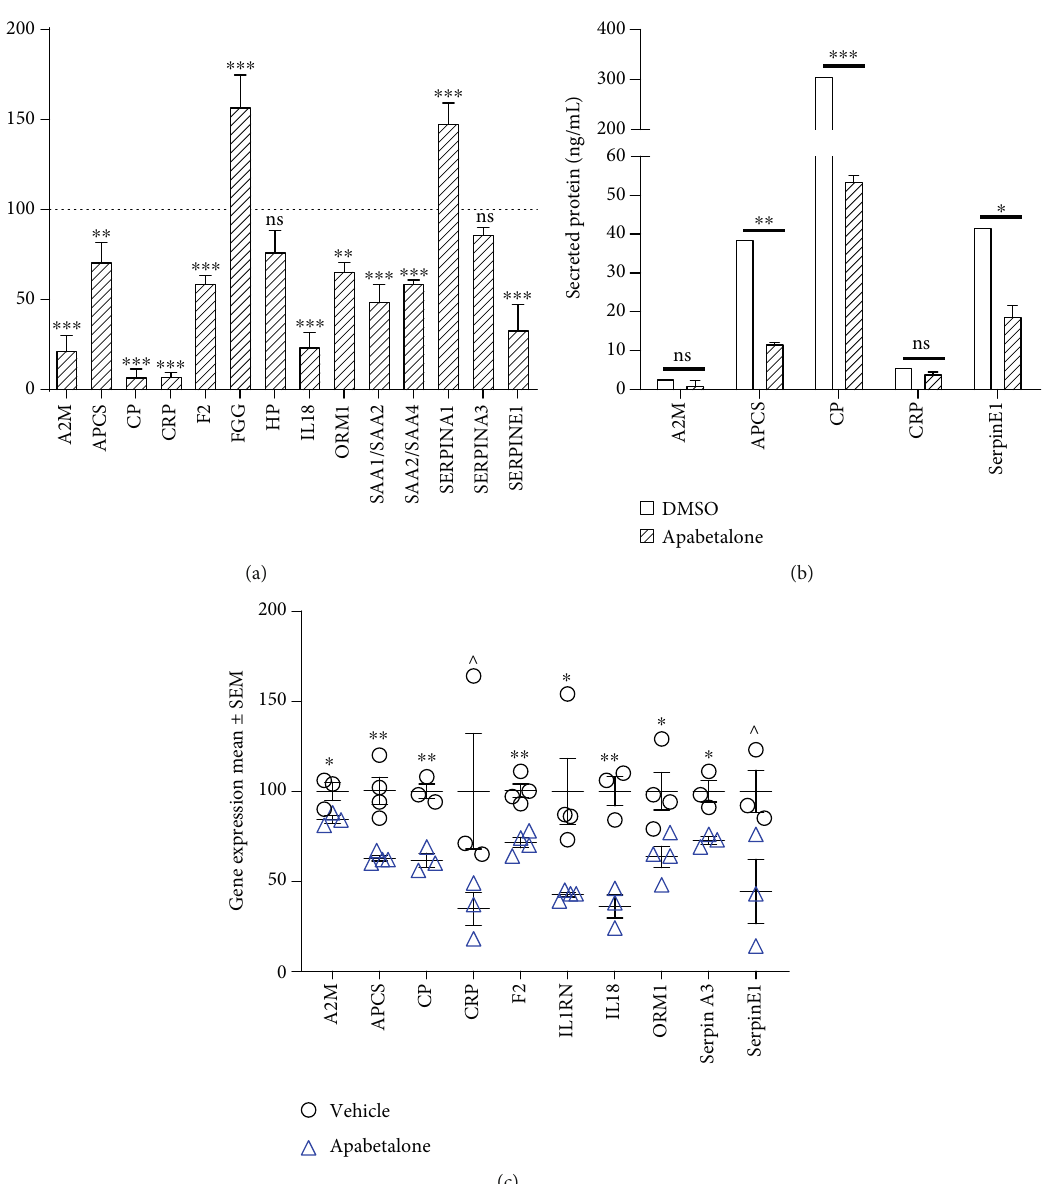
Figure 1: Apabetalone alters basal expression of genes within the APR pathway under nonin fl ammatory conditions in human hepatocytes. (a) rtPCR shows that apabetalone (30 μ M) treatment decreases the expression of APR genes (72 h). Gene expression is normalized to vehicle (DMSO) treated cells. (b) Apabetalone (30 μ M) decreases APR protein secretion after 72 h of treatment. Protein secretion in the fi nal 24h of treatment is measured by ELISA and is expressed as nanograms per milliliter of tissue culture media. Representative data mean ± S : D : is shown. (c) APR gene expression in humanized liver of chimeric mice. Mice received 150 mg b.i.d. apabetalone or vehicle treatment for 1 to 3 days. Mean data normalized to naïve samples ± S : E : M : is shown. Statistical signi fi cance was determined through t - test comparison of vehicle and apabetalone treatment, where ∗ p < 0 : 05 , ∗∗ p < 0 : 01 , ∗∗∗ p < 0 : 001 , and ns means no signi fi cant di ff